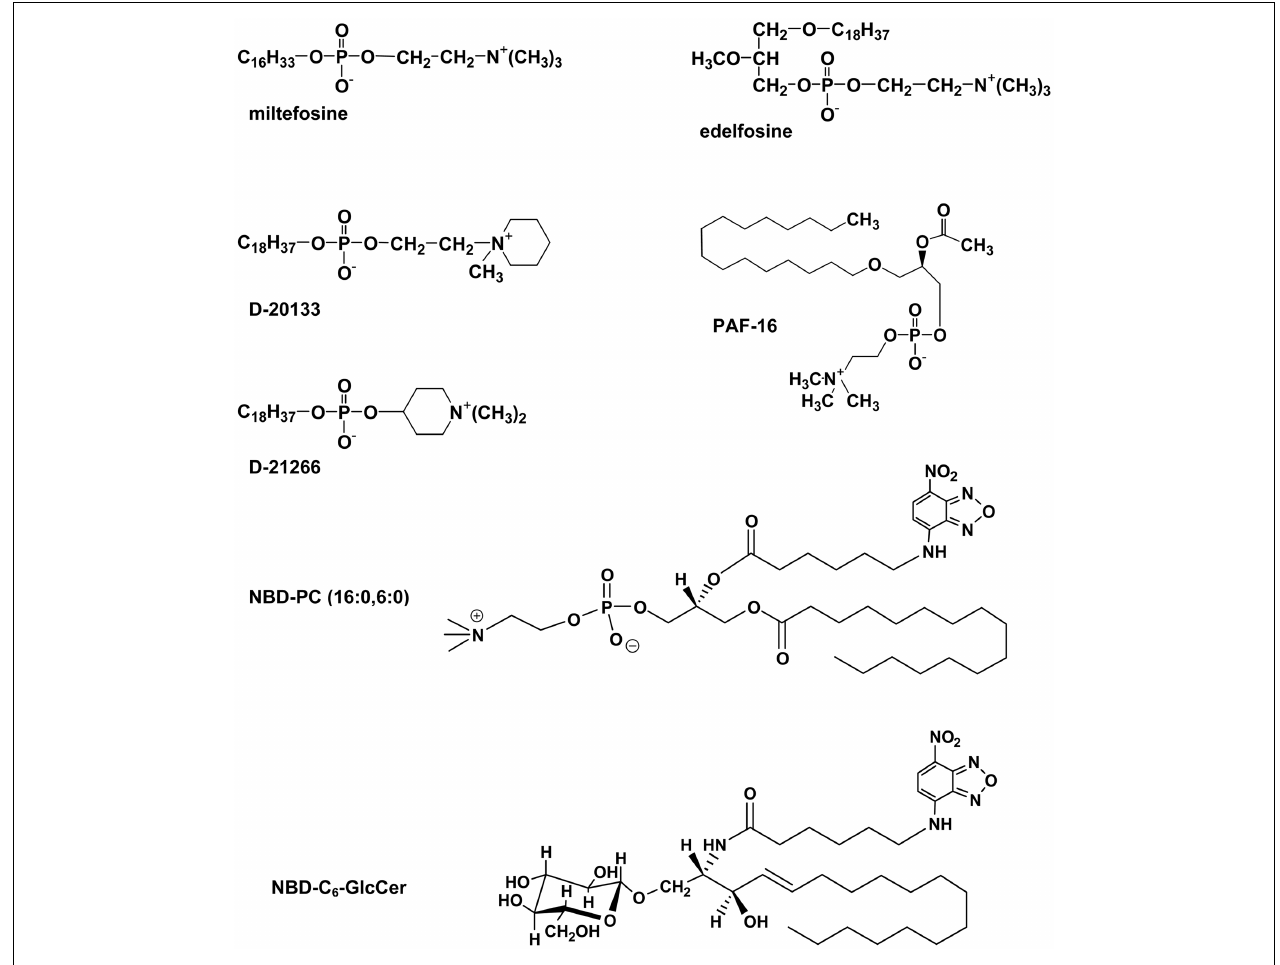
FIGURE 2 | Structures of some lipid-based Pgp substrates